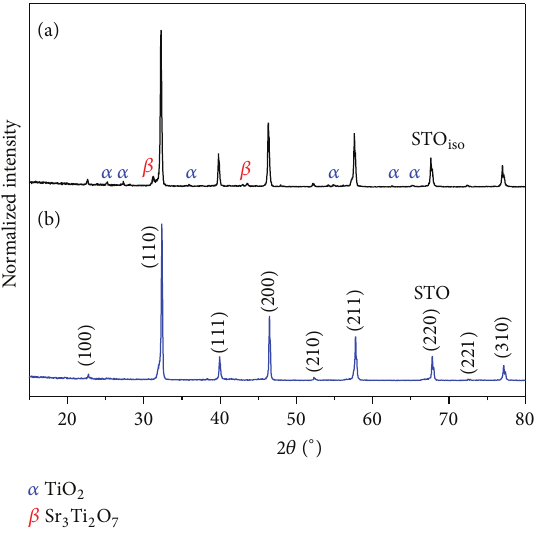
Figure 1: XRD patterns of (a) STO iso and (b) STO sample.